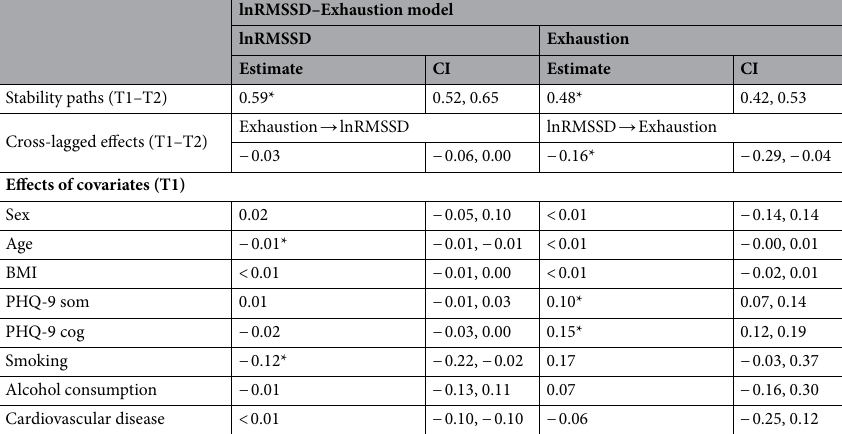
Table 2. Path coefficients of cross-lagged panel models on exhaustion symptoms and lnRMSSD with covariates. Sex is coded 0 = male, 1 = female; BMI = body mass index; Cardiovascular Disease = self-reported hypertension and/or cardiac arrhythmias; CI = confidence interval; PHQ-9 cog = Patient Health Questionnaire 9—cognitive factor; PHQ-9 som = Patient Health Questionnaire 9—somatic factor; lnRMSSD = root mean square of successive difference between heart beats, logarithmized; T1 = first attended measurement time point; T2 = measurement time point with the largest time-lag to T1. *CI does not include